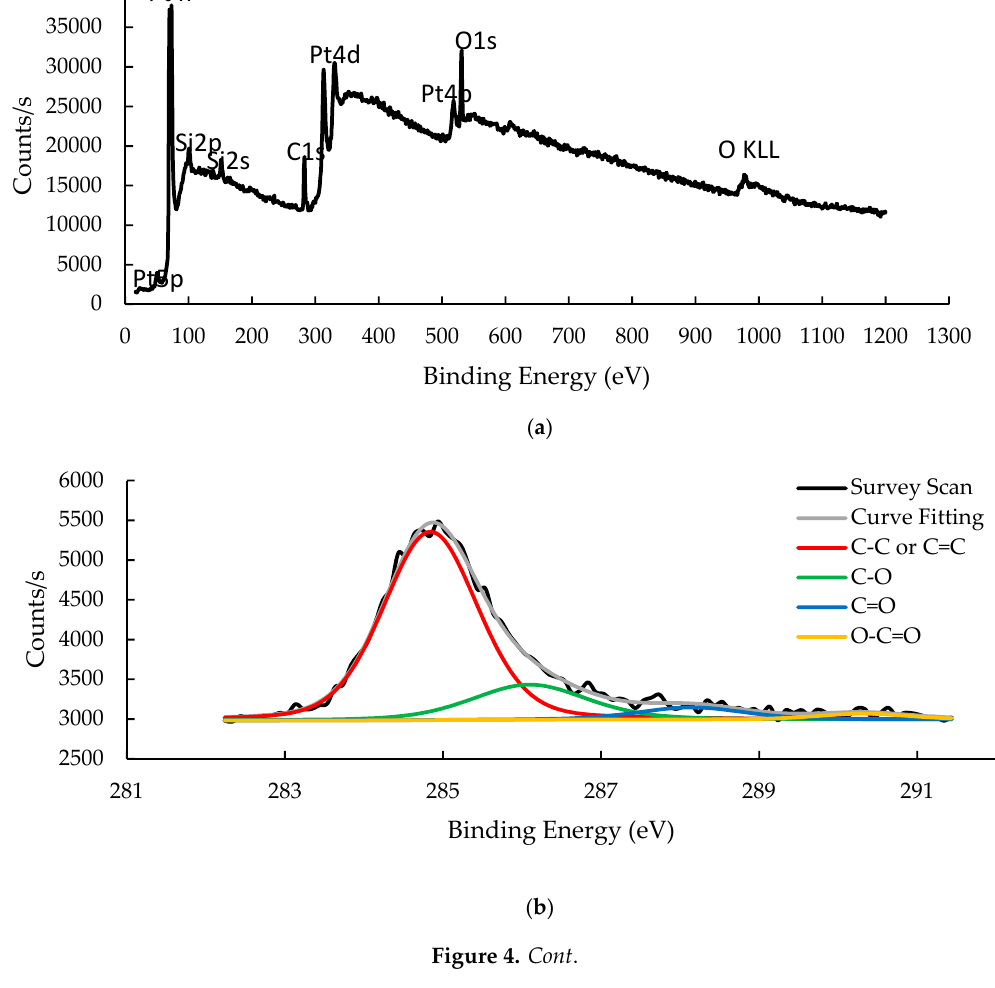
Figure 4 . Cont. Figure 4. Cont